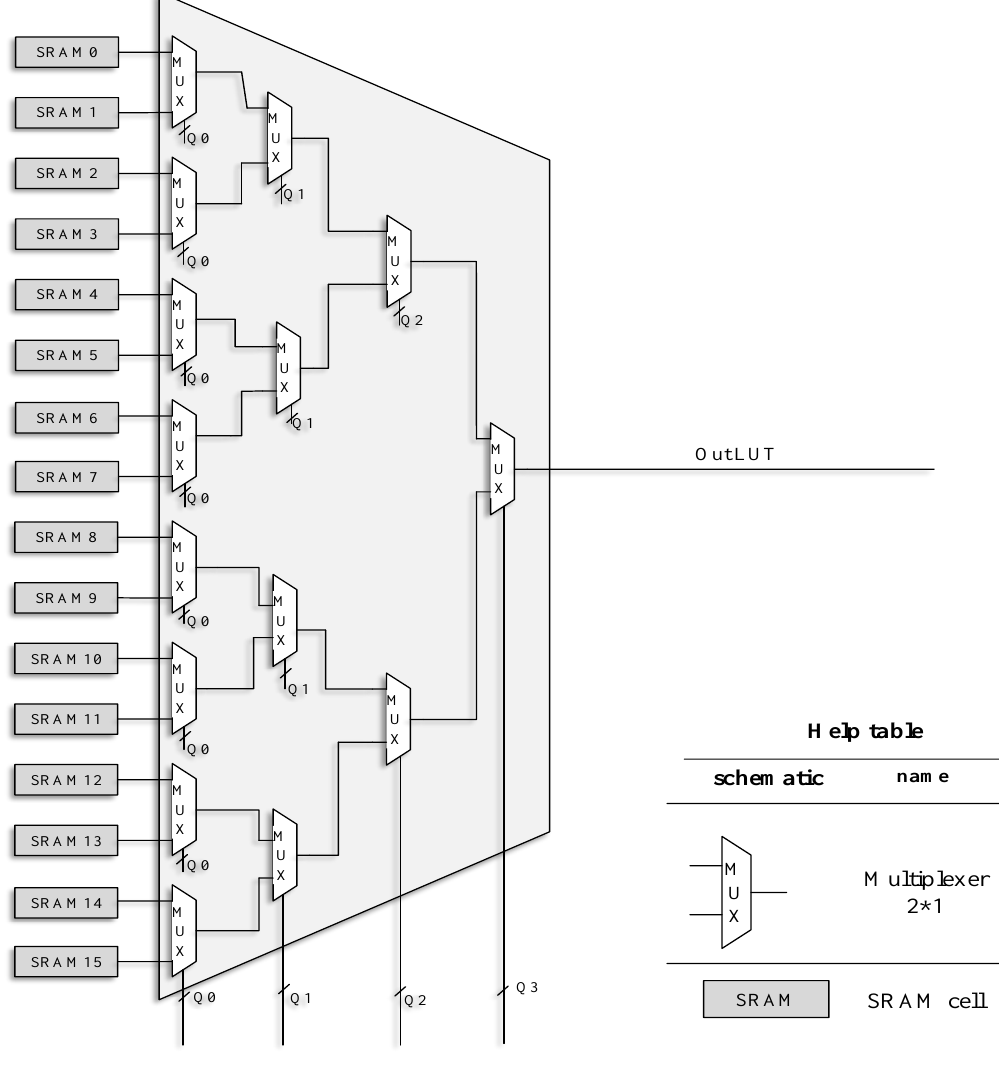
Figure 4. The structure of a